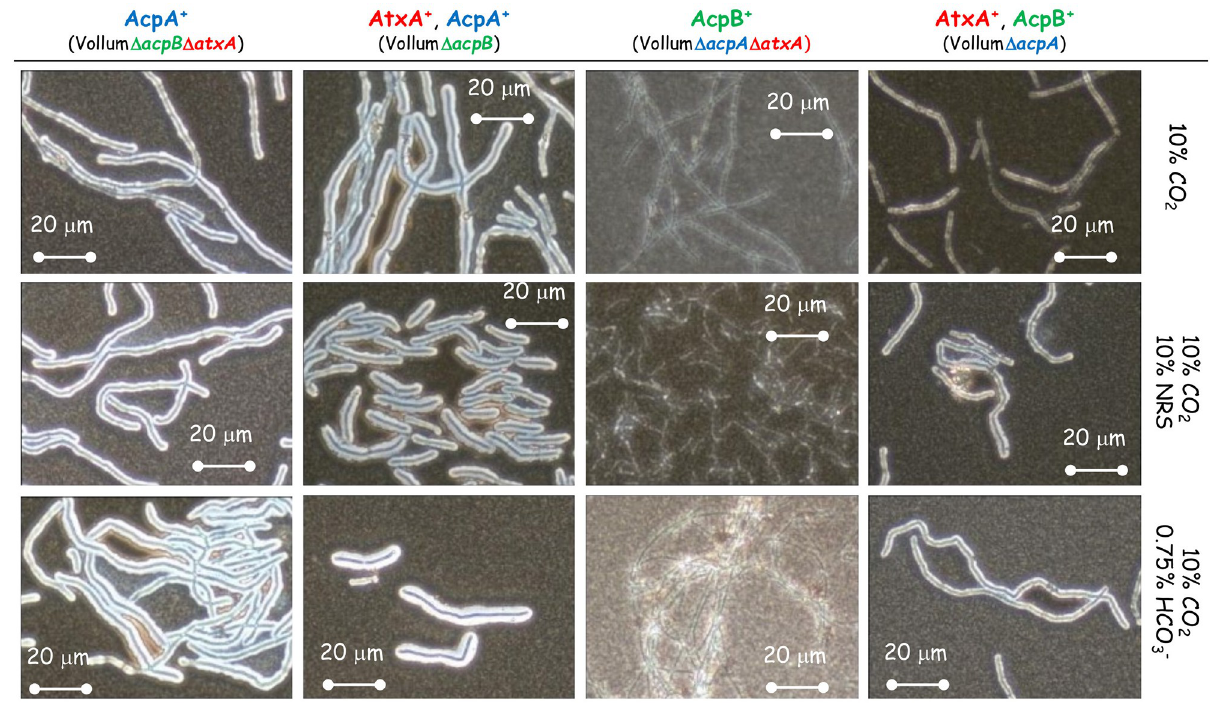
Fig 5. Effect of AtxA on capsule production in the presence of either AcpA or AcpB. Spores of the different mutants (top panel) were seeded into 100 μ l of sDMEM as is or supplemented with 0.75% HCO 3- or 10% NRS and incubated at 37˚C in 10% CO 2 atmosphere (as indicated on the right) for 24h. Capsule was imaged by India ink negative staining (capsule presence forms a typical bright outer layer).